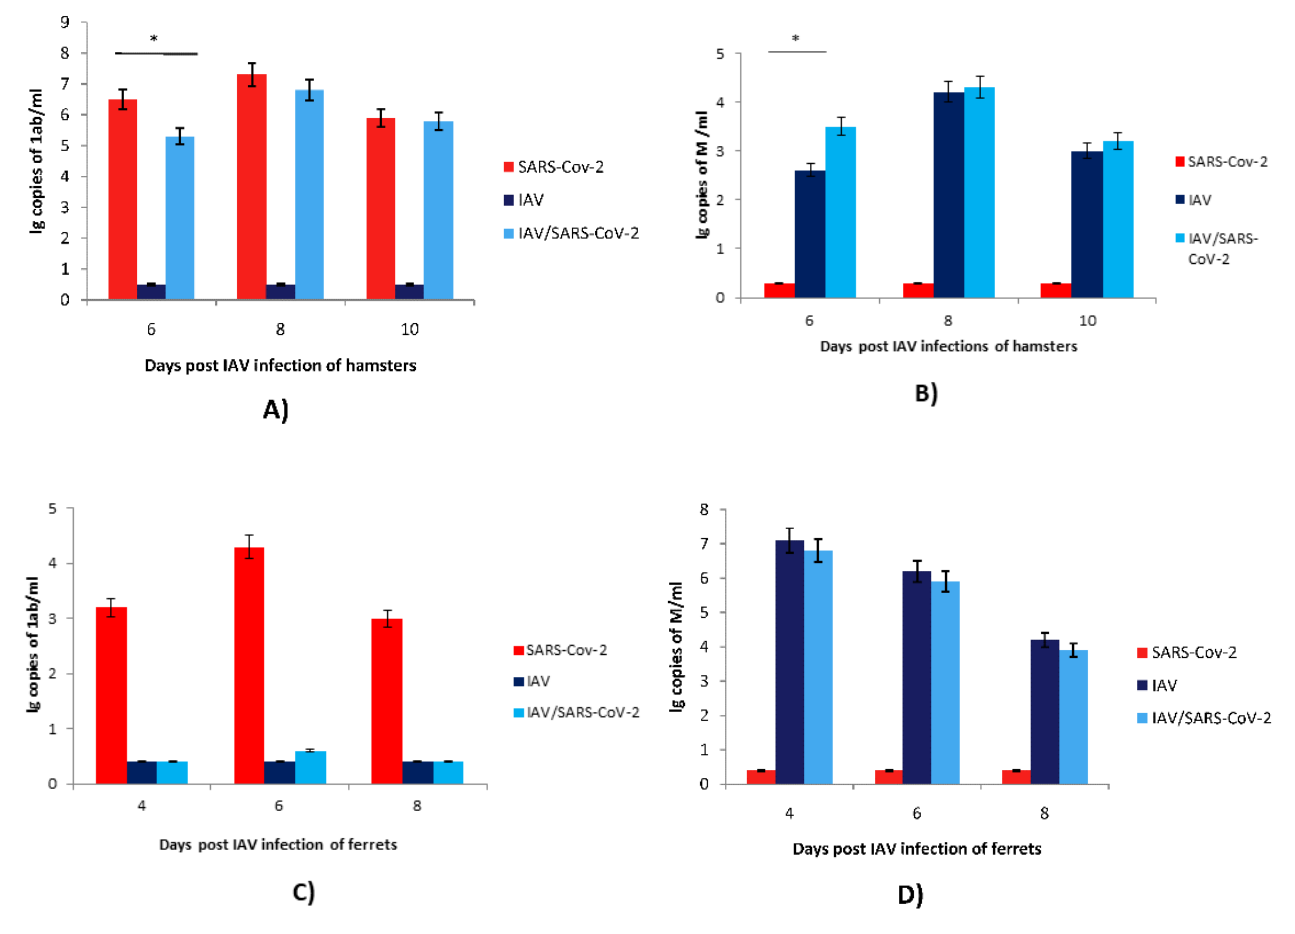
Figure 3. SARS-CoV-2 and IAV replication in monoinfected and coinfected hamsters and ferrets. ( A , C ) SARS-CoV-2 viral genome loads were determined using qPCR for the 1ab gene in nasopharyngeal washes of hamsters and ferrets, respectively. ( B , D ) IAV viral genome loads were determined using qPCR for the M gene in nasopharyngeal washes of hamsters and ferrets, respectively. SARS-CoV-2 — the Syrian hamsters and ferrets were intranasally challenged with SARS-CoV-2 (10 4 TCID 50 and 3 × 10 5 TCID 50 , respectively); IAV — the Syrian hamsters and ferrets were intranasally challenged with IAV (2 × 10 3 TCID 50 and 10 2 TCID 50 , respectively); IAV/SARS-CoV-2 — the Syrian hamsters were intranasally challenged with IAV (2 × 10 3 TCID 50 ) and, 4 days later, with SARS-CoV-2 (10 4 TCID 50 ); the ferrets were intranasally challenged with IAV (10 2 TCID 50 ) and, 2 days later, with SARS-CoV-2 (3 × 10 5 TCID 50 ). On Days 6, 8, and 10 after infection with IAV for the hamsters and on Days 4, 6, and 8 after infection with IAV for the ferrets, nasopharyngeal washes were collected from all animals to determine the viral genome loads. The nasopharyngeal washes were analyzed by qPCR. The SARS-CoV-2 and IAV viral genome loads were determined using primers targeting the 1ab and M genes, respectively. The values represent the means ± SDs of three individual animals.